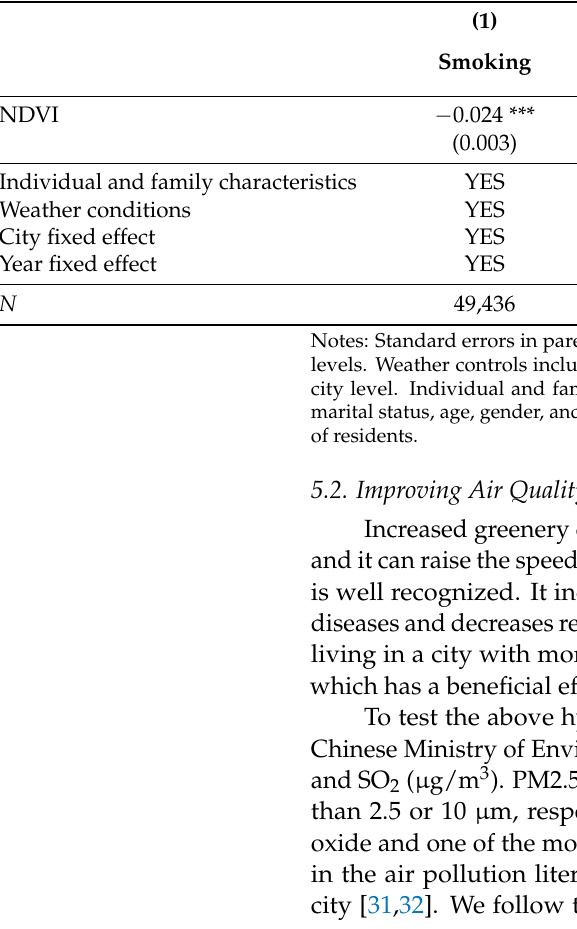
Table 8. Fostering healthy